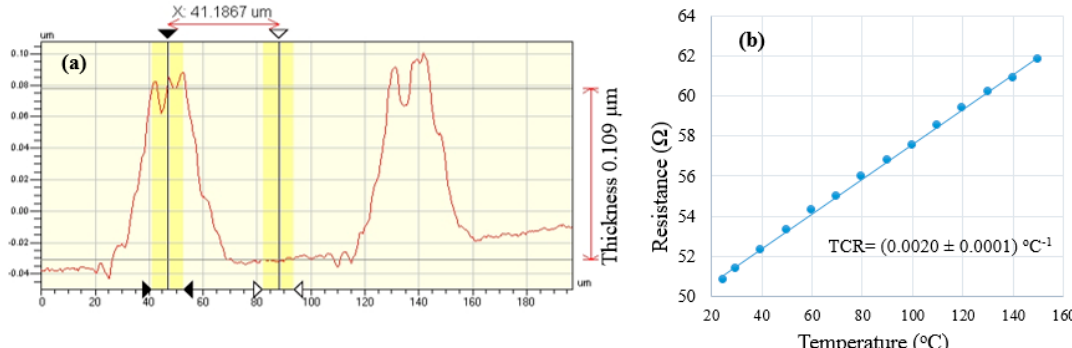
Figure 2. ( a ) Optical profilometry of the printed Au printed patterns; ( b ) Resistance as a function of temperature (TCR) for Au micro-hotplates on PI, (TCR = 0.0020 ± 0.0001/°C).